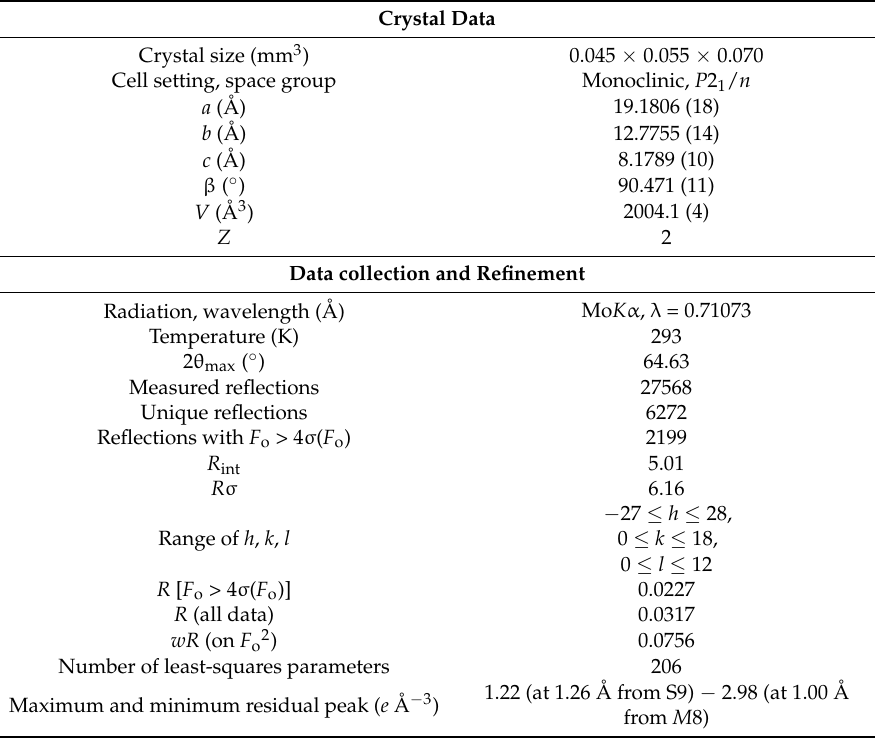
Table 2. Crystal and experimental details for oyonite.